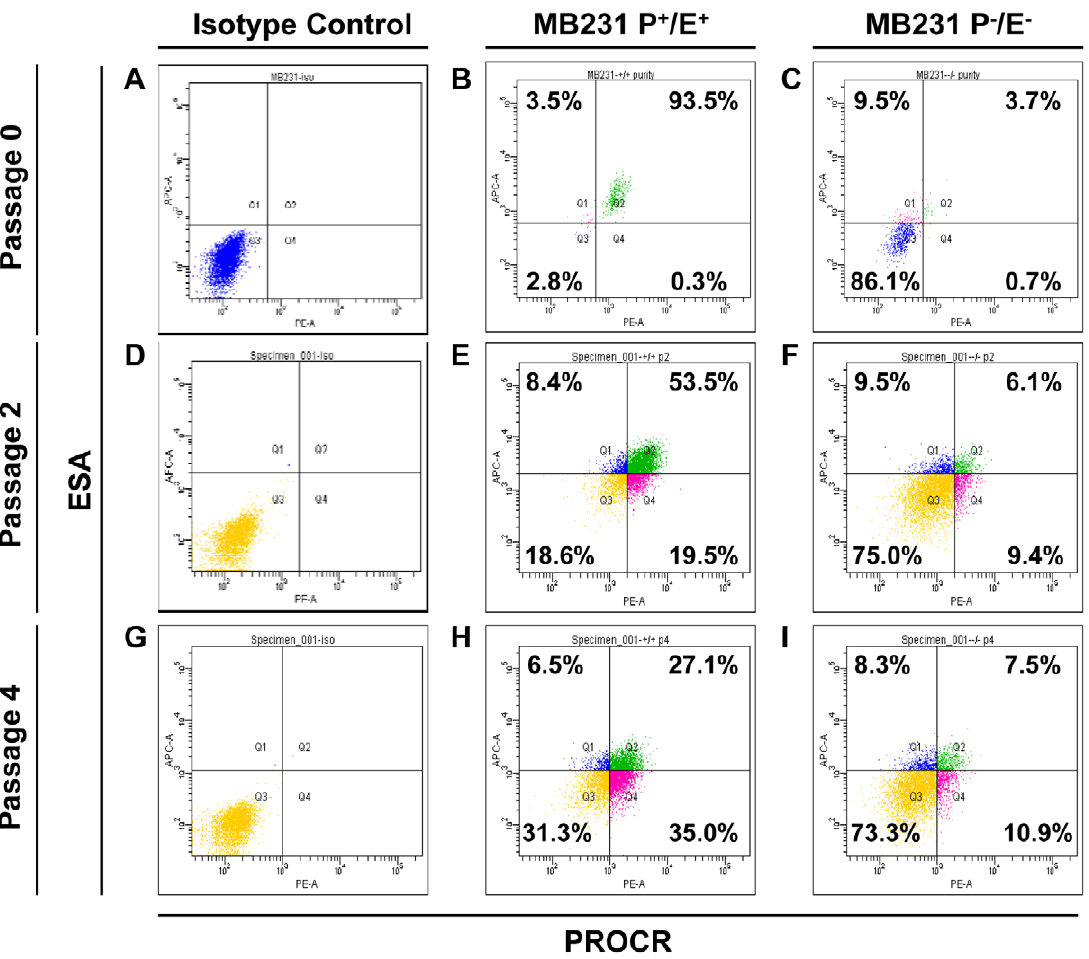
Figure 2. PROCR/ESA marker profiling of PROCR + /ESA + and PROCR 2 /ESA 2 MDA-MB-231 cells invitro to evaluate their asymmetric division. PROCR + /ESA + (B) and PROCR 2 /ESA 2 (C) cells were sorted and cultured for four passages in an attachable culture system. The PROCR/ESA marker profile was evaluated at passage 2 (E, F) and 4 (H, I). Isotype control cells were assayed at each time point as indicated (A, D, G). The PROCR + / ESA + subpopulation was able to asymmetrically divide into other subpopulations in vitro ; however, the PROCR 2 /ESA 2 subpopulation was not capable of asymmetric division.